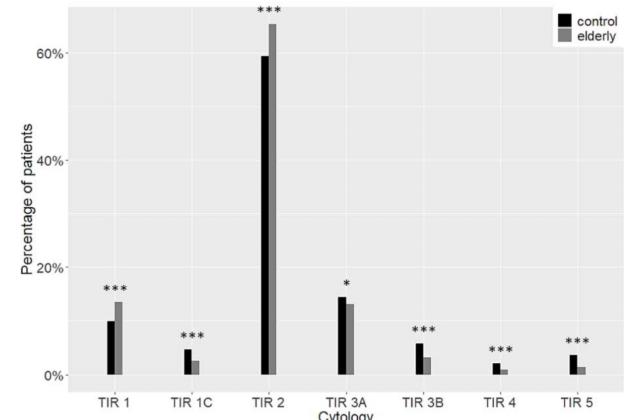
Figure 1. Distribution of cytological diagnoses. Differences between the elderly (grey) and the control group (black) are highlighted. * p < 0.05 *** p <